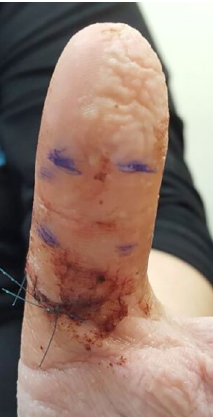
Figure 1. The injured digit distal to the laceration showing no wrinkling while the healthy side is wrinkled.